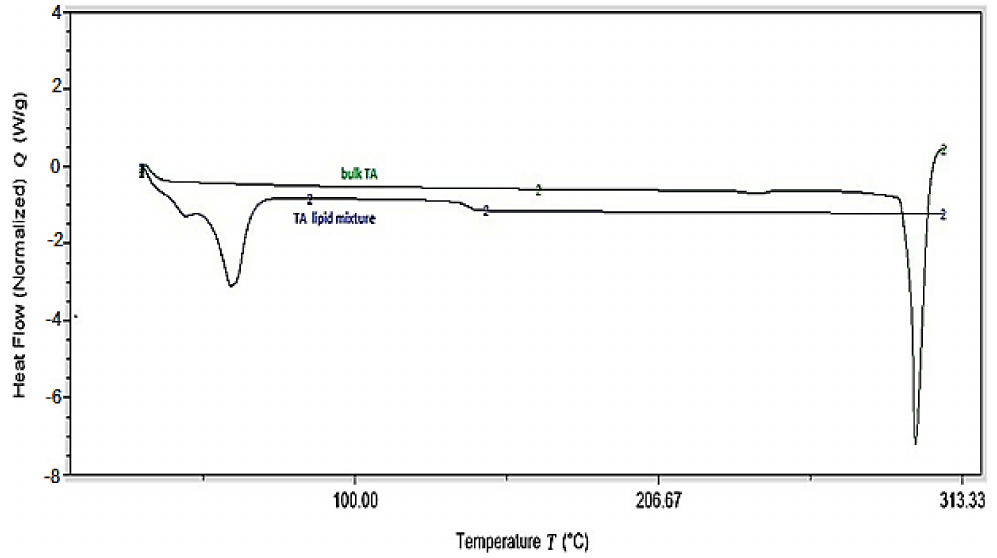
Figure 1. DSC thermograms of pure drug and physical mixture of